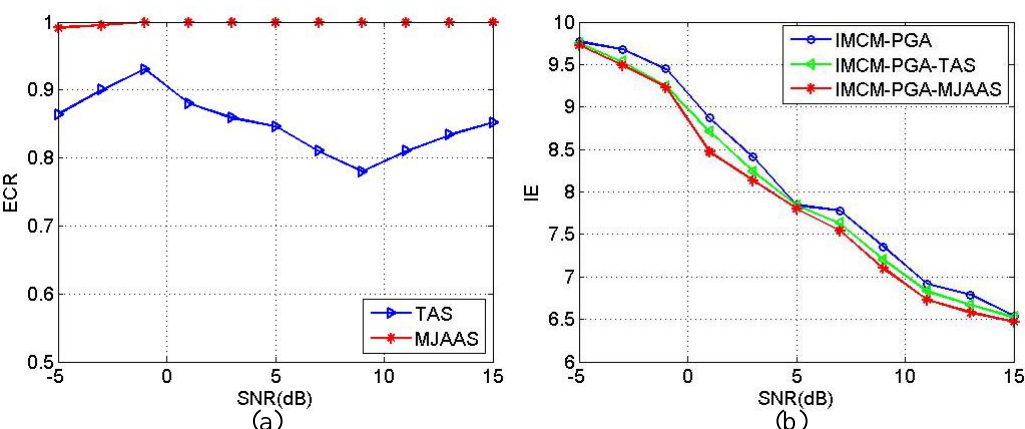
Figure 14. The relationship curve between ECR and SNR and the relationship curve between IE and SNR. ( a ) ECR. ( b )